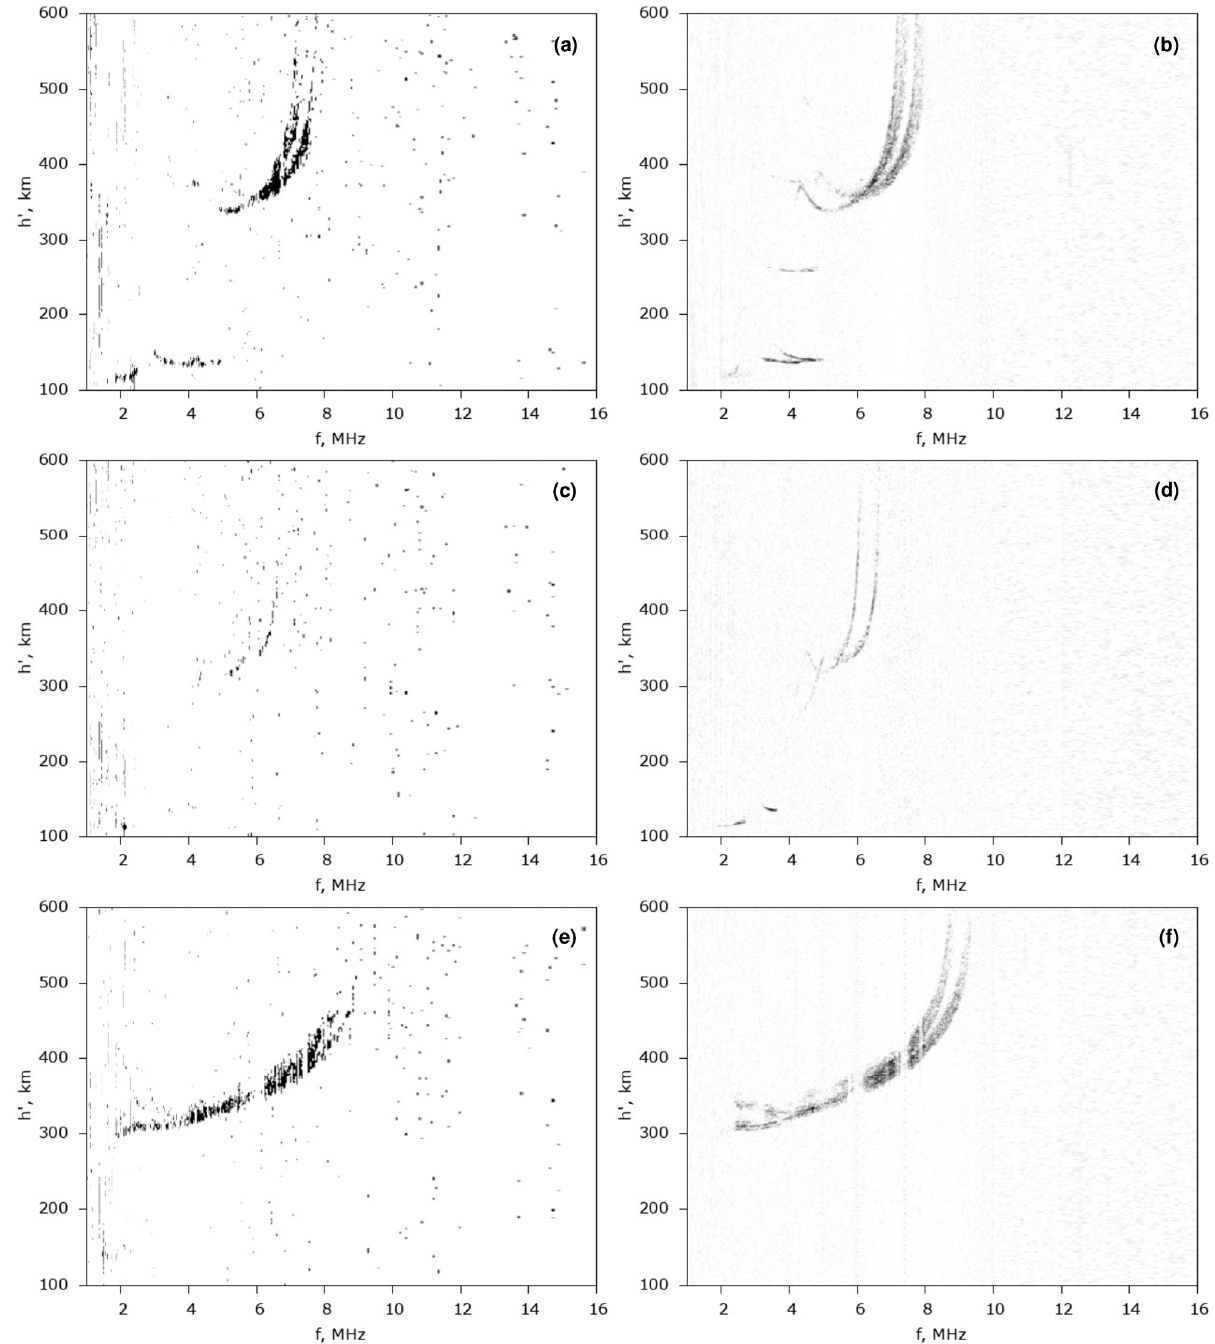
Figure 11. Ionograms obtained on 28 December 2021 at: 07:00 LT ( a ) by IPS-42, ( b ) by ISDR; 16:00 LT ( c ) by IPS-42, ( d ) by ISDR; 23:00 LT, ( e ) by IPS-42, ( f ) by ISDR. The inverted diurnal variations of the foF2 parameter (maximum at nighttime instead of noon) is attributed to what is called the “Weddell Sea Anomaly” [50,51]. It can be related to the distribution of the thermospheric winds [52] or the effects of the tidal and stationary planetary waves [53].